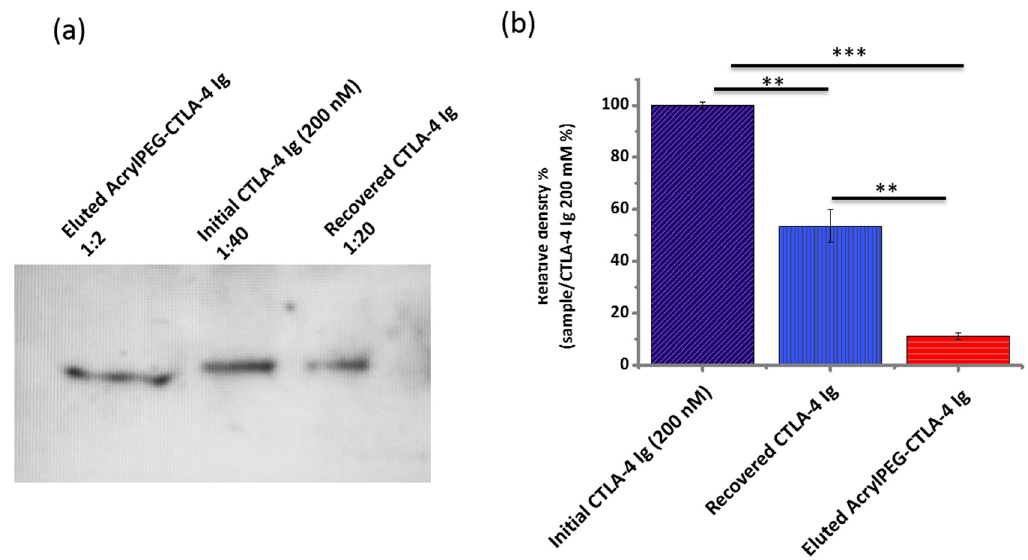
Figure 12. Western blot analysis ( a ) and relative density percentage ( b ) of mother solution of CTLA-4 Ig (dark blue bar), CTLA-4 Ig recovered after incubation (light blue bar) and Acryl-PEG-CTLA-4 Ig complex eluted from the solid substrate (red bar). Reported values have been averaged over three measurements. Error bars represent standard deviation (SD) (*** p < 0.001, ** p < 0.01).